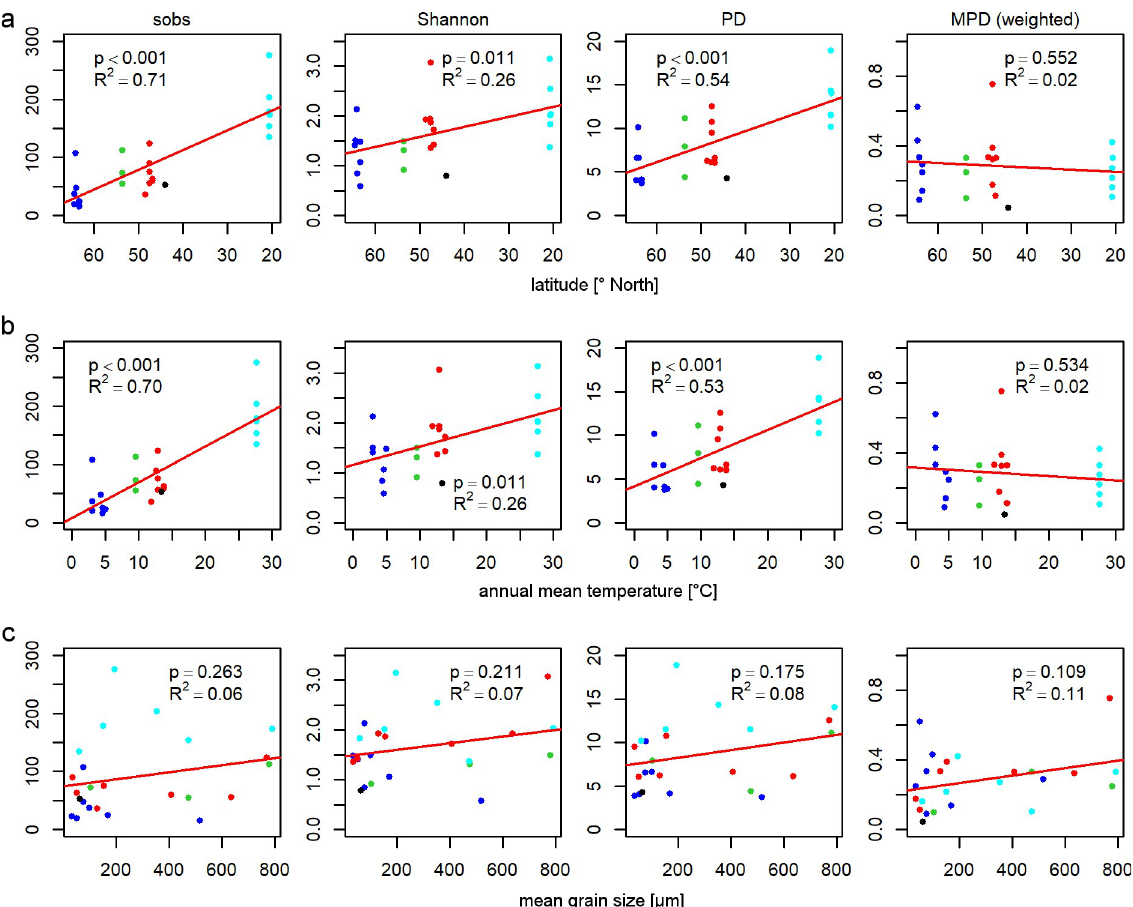
Fig 2. Linear regression analyses of OTU- and phylogeny-based alpha diversity estimates in relation to latitude (a), annual mean temperature (b), and mean grain size (c). OTU-based alpha diversity was described as observed richness (sobs) and Shannon diversity (Shannon), phylogeny based alpha diversity as Faith’s phylogenetic diversity (PD), and Mean pairwise distances (MPD, abundance weighted) for representative sequences per OTU based on a maximum likelihood tree; annual mean temperatures adopted from https://eosweb.larc.nasa. gov/sse/ (accessed 21.09.2017) as averaged monthly values of a 22-years period (1983–2005); colors code locations: dark blue = Iceland, green = Germany, red = France, black = Croatia, light blue = Oman.